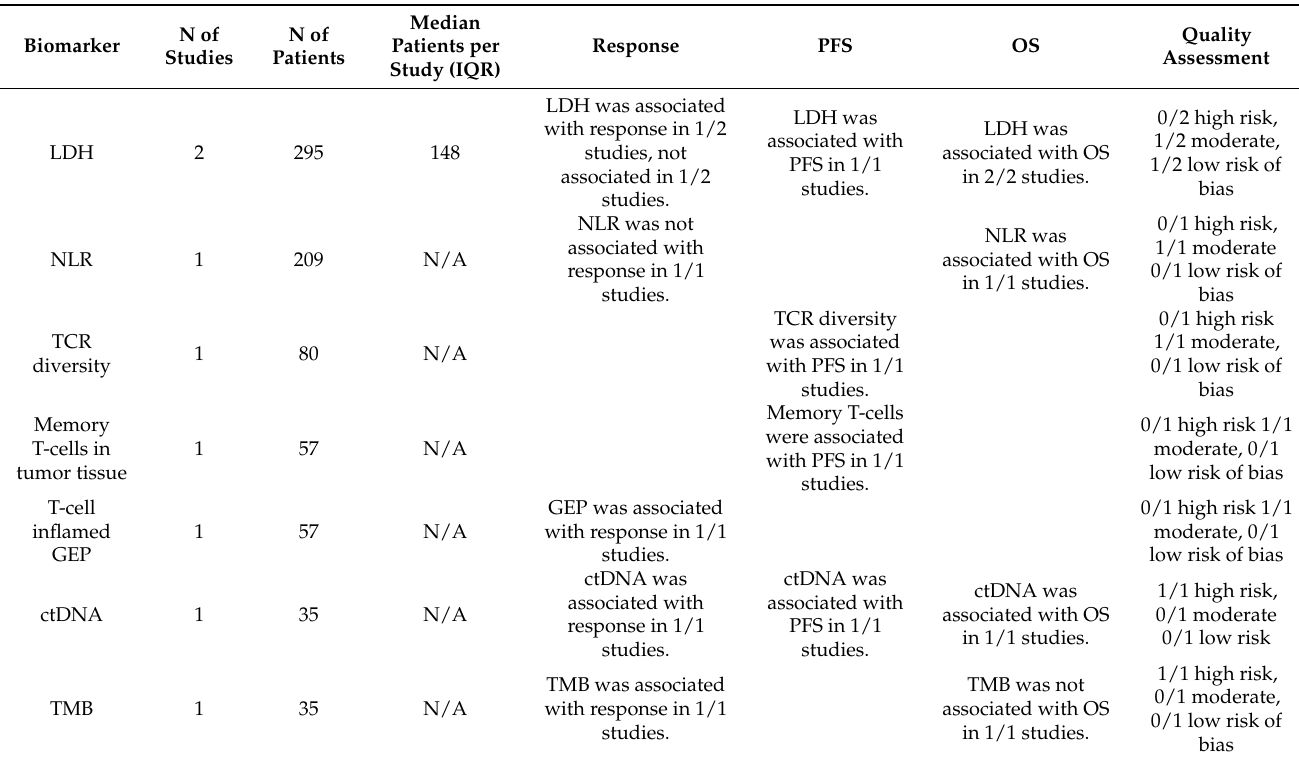
Table 3. Summary of most important biomarkers that were studied for combination therapy and assessed risk of bias per article.